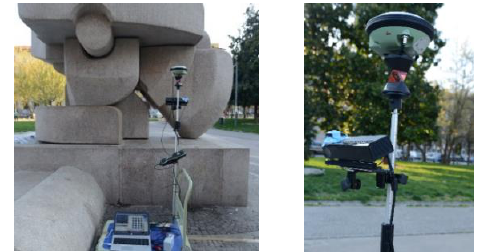
Figure 7. The cart used for the experimental test with all the instruments installed on